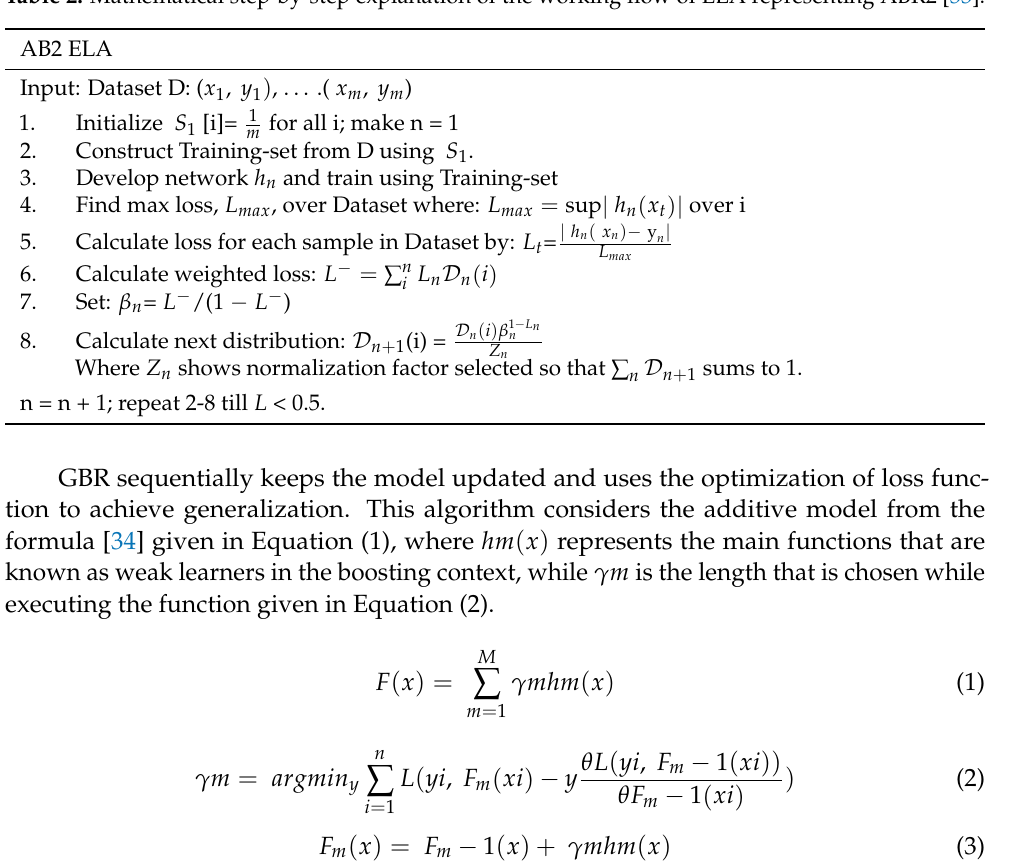
Table 2. Mathematical step-by-step explanation of the working flow of ELA representing ABR2